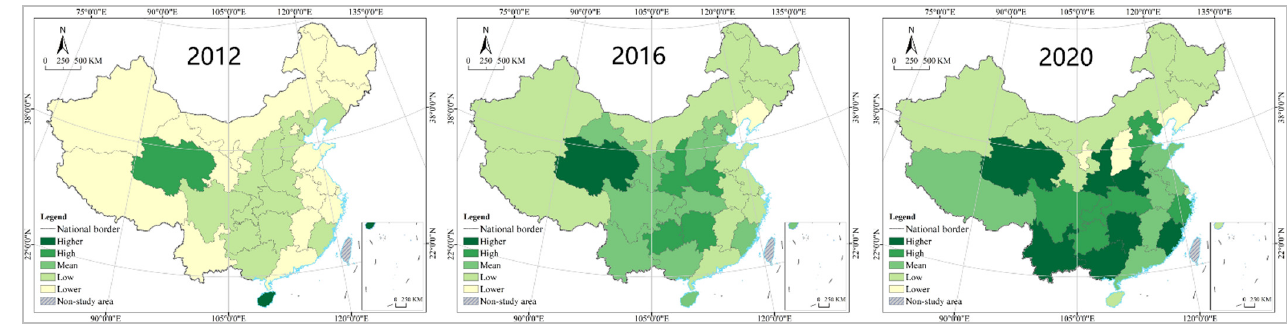
Figure 15. Analysis of spatial clustering of per unit area investment.